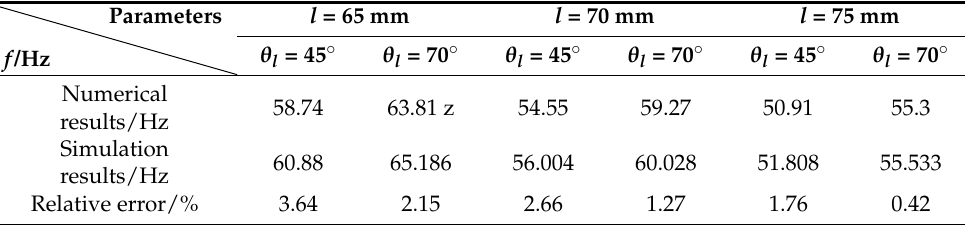
Table 4. Comparison of numerical calculation results and finite element simulation of six models with different